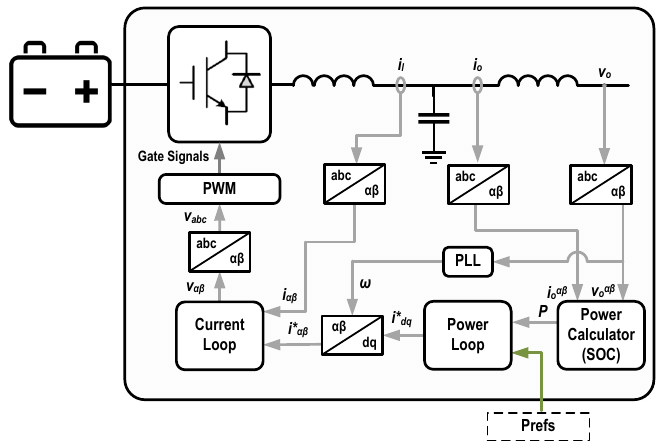
Figure 12. Control structure of grid-feeding